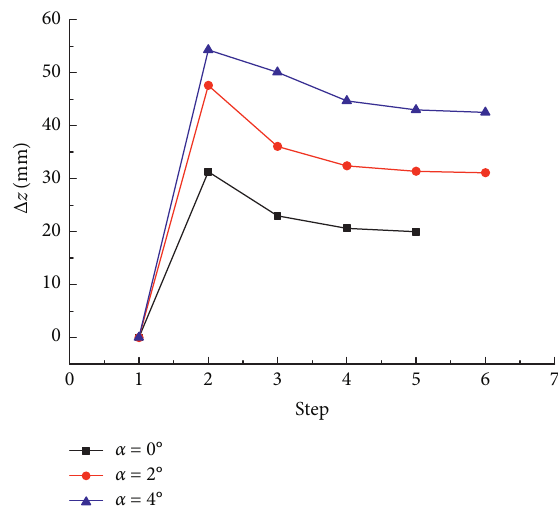
Figure 5: Iteration convergence of static aeroelastic